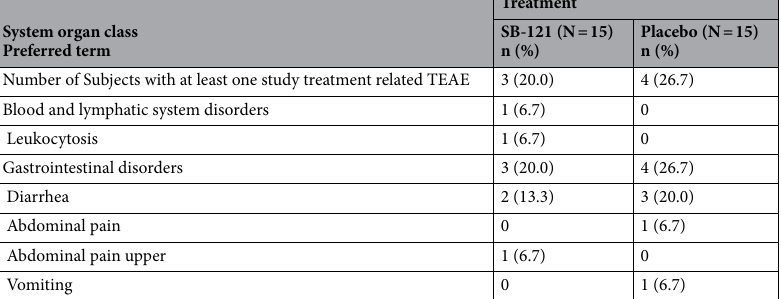
Table 3. Treatment related